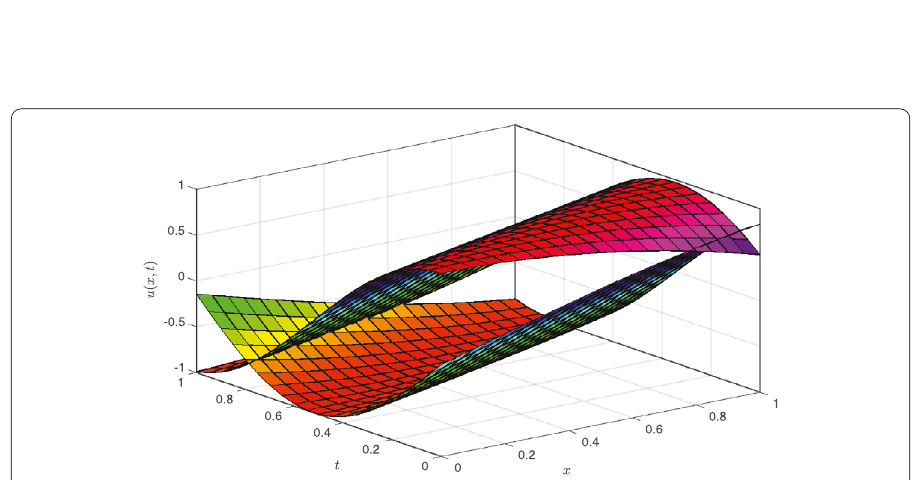
Figure 10 The approximate solution of Example 2 for Case 2 and α = β =